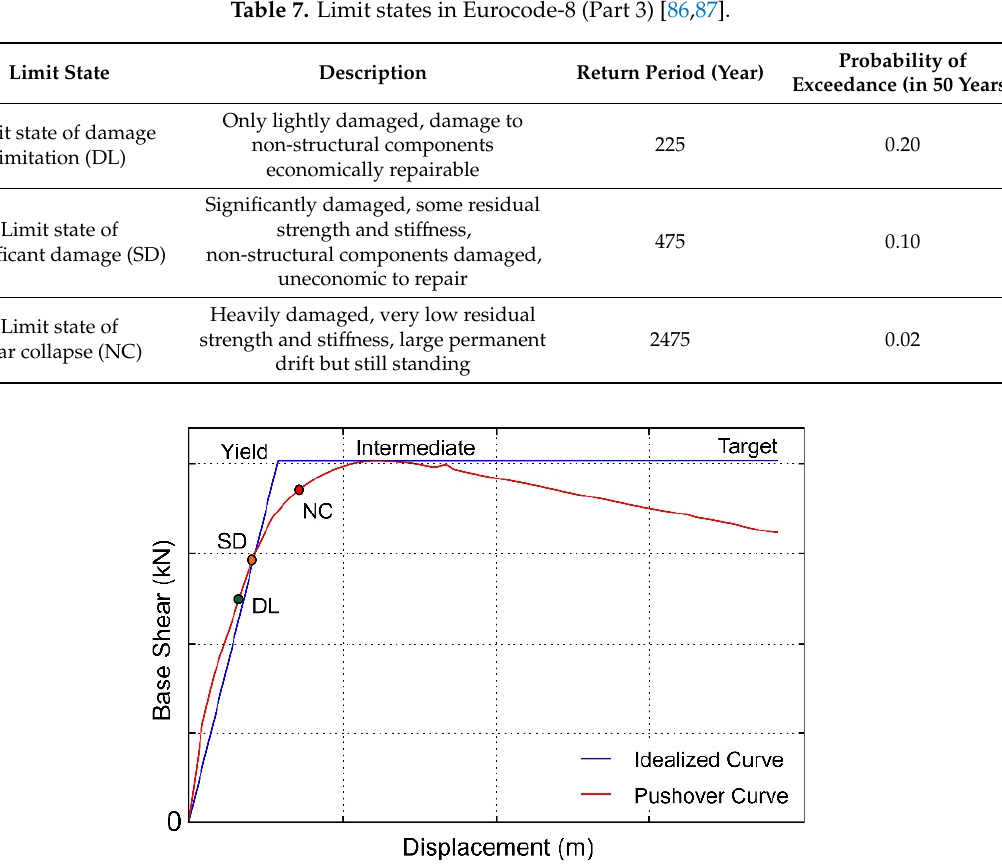
Table 7. Limit states in Eurocode-8 (Part 3) [86,87].